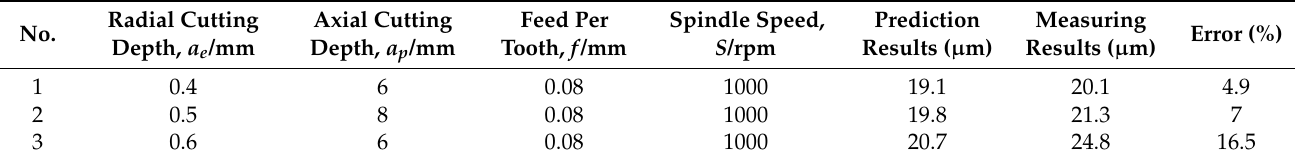
Table 1. Comparison of simulation and experimental results of